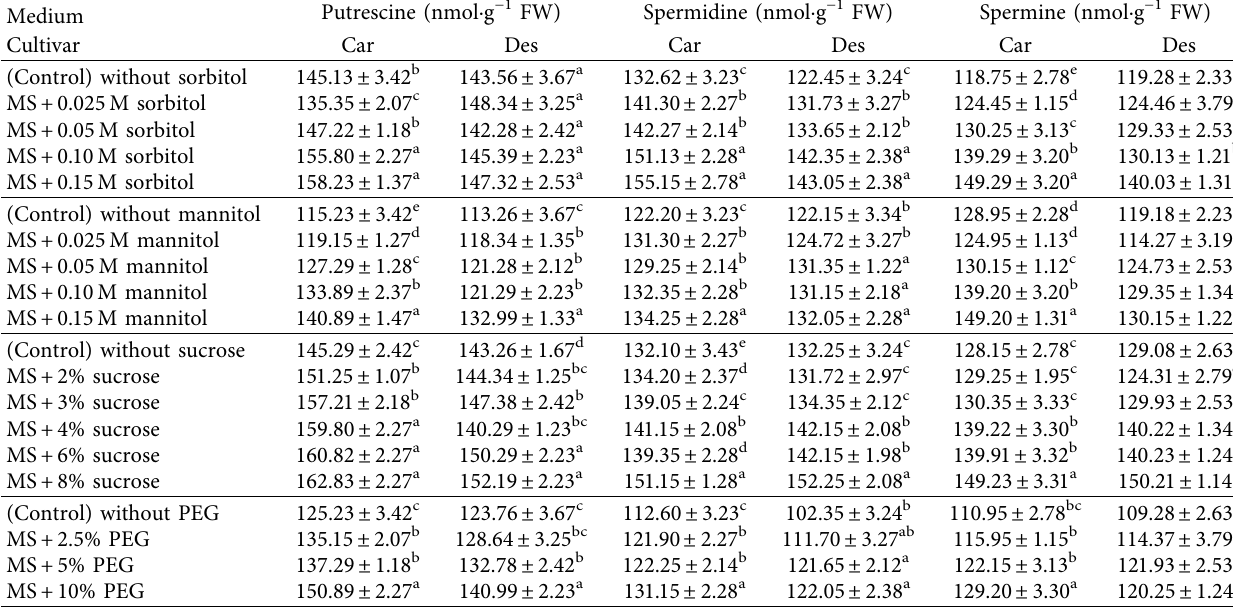
Table 2: Effect of various levels of sorbitol, mannitol, sucrose, and PEG on polyamines contents (putrescine, spermidine, and spermine) of potato plants.